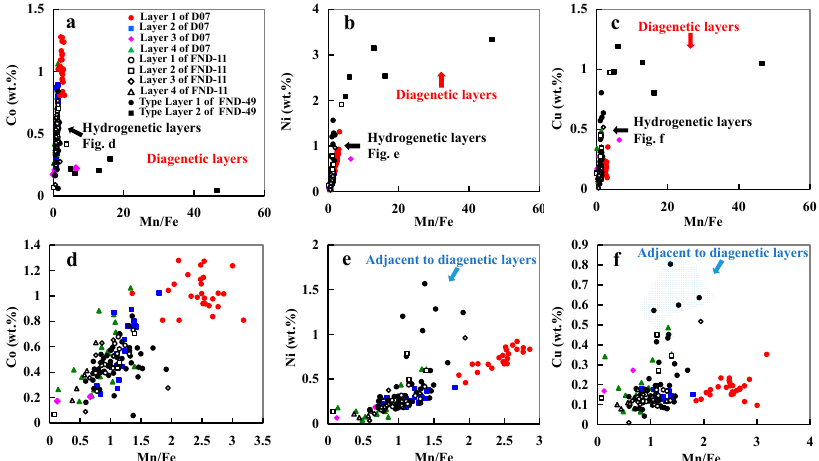
Figure 9. ( a – c ): Relationships of Mn/Fe with Co, Ni, and Cu of all points in the nodules; ( d – f ): Relationships of Mn/Fe with Co, Ni, and Cu of points in the hydrogenetic layers.